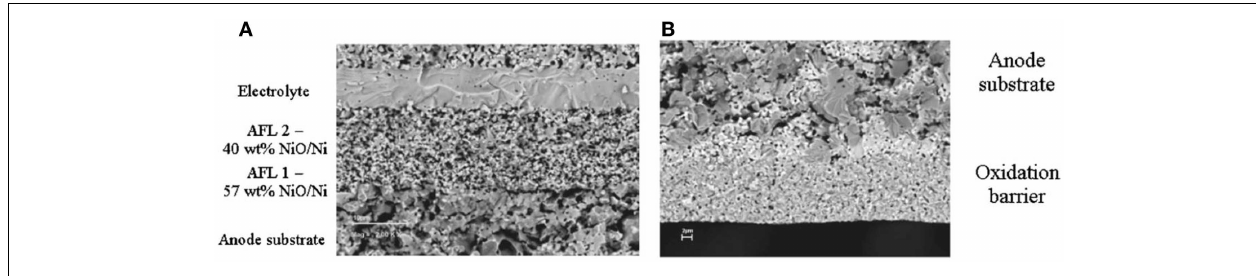
FIGURE 3 | BSE SEM images of (A) a reduced fuel cell with a graded anode functional layer, (B) an as-prepared 57wt% NiO oxidation barrier (Waldbillig et al., 2007) . Reprinted with permission fromThe Electrochemical